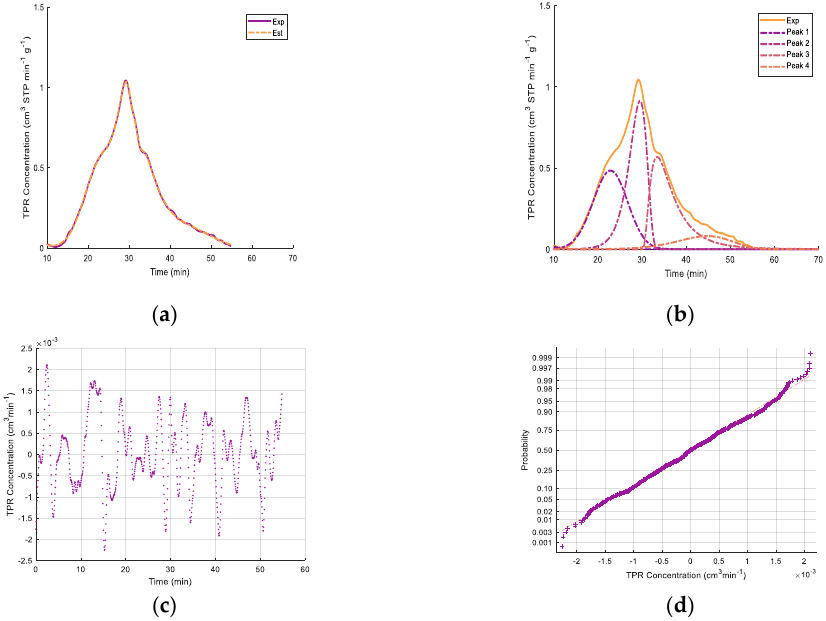
0.999, ( b ) composition curves, ( c ) regression residues, ( d ) probability distribution of the adjustment curve